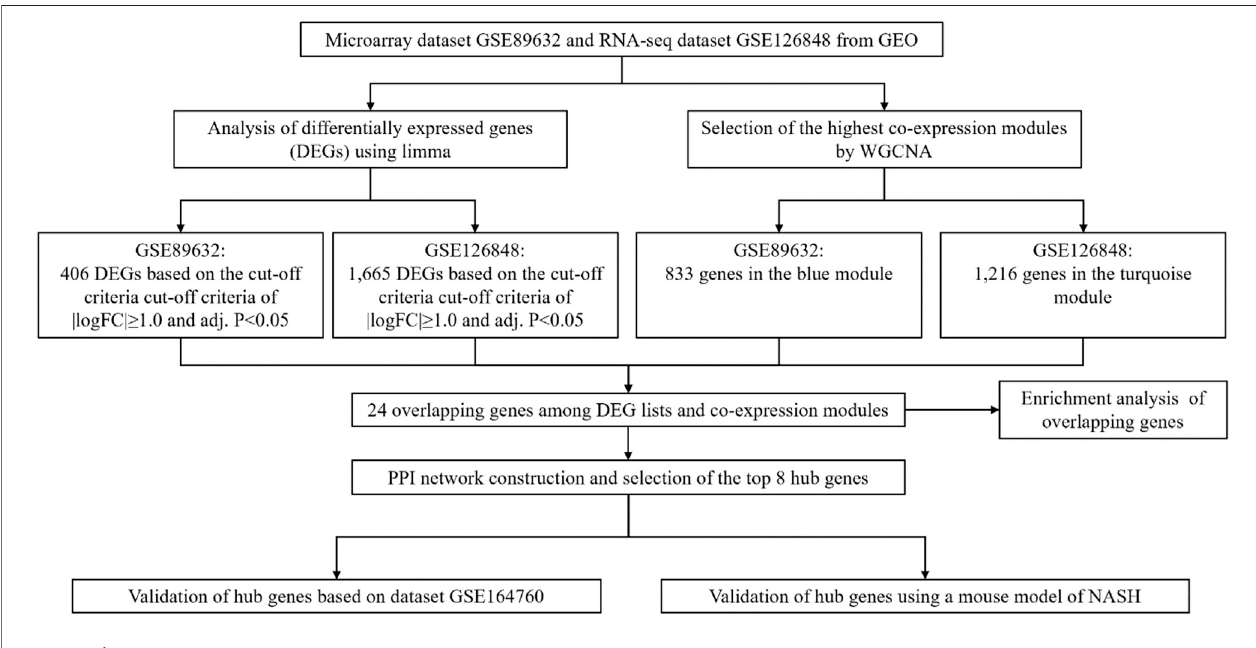
FIGURE 1 | Work fl ow of this study.